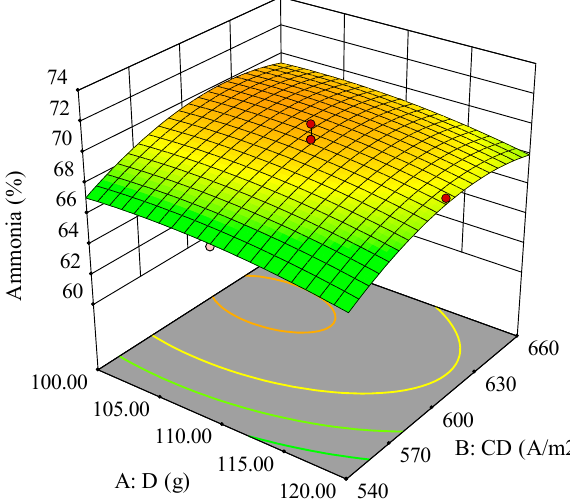
Figure 7. 3D surface plots for removal of ammonia on influences of dosage and current density.